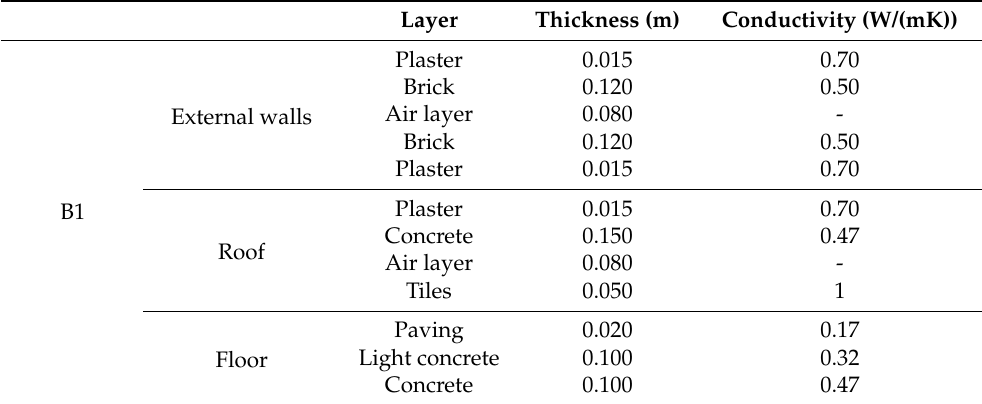
Table 2. Stratigraphy of most important building envelope components for the three buildings con- sidered.